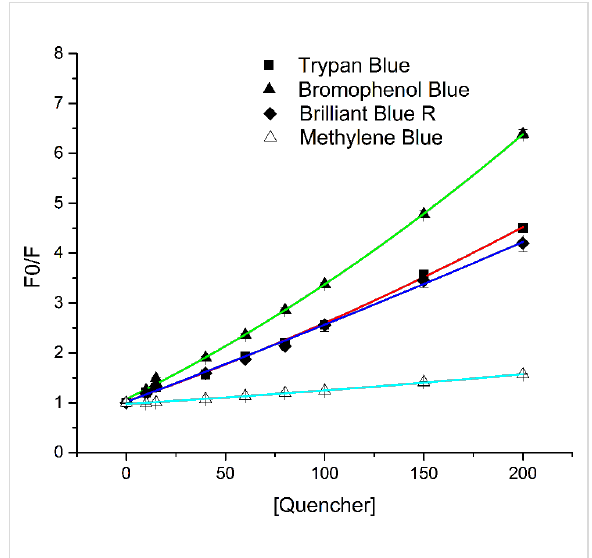
Figure 3: Comparison of quenching 2 µM NBDM, as measured by fluorescence intensity of Trypan Blue, Bromophenol Blue, Brilliant Blue R, and Methylene Blue. Each data set was plotted in OriginPro 8.6 and fitted using a polynomial fit (order = 2) with direct weighting.